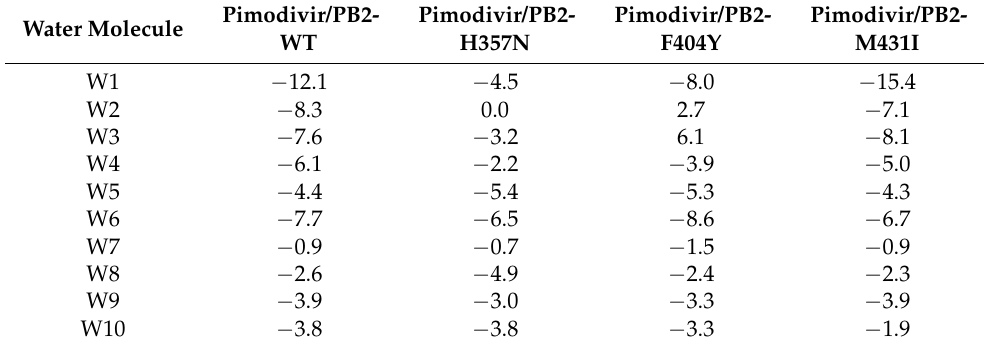
Table 3. The PM6-D3H4X binding “free” energies of the active site water molecules. All in kcal.mol − 1